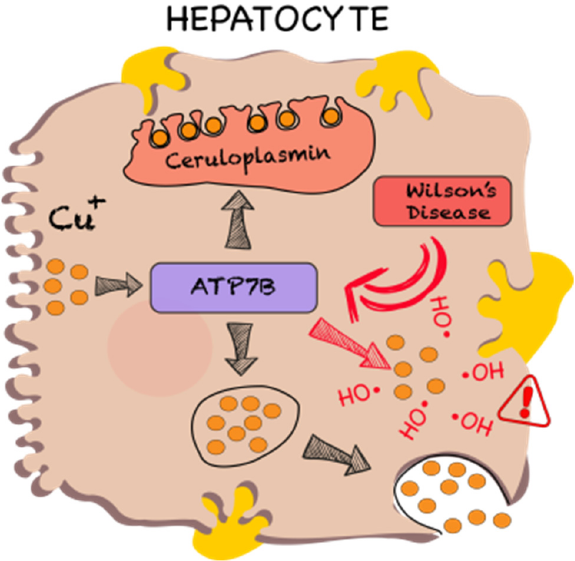
Figure 6. Mechanism of copper accumulation in hepatocyte. Reprinted with permission from Reference [84]. Copyright 2021 Elsevier.